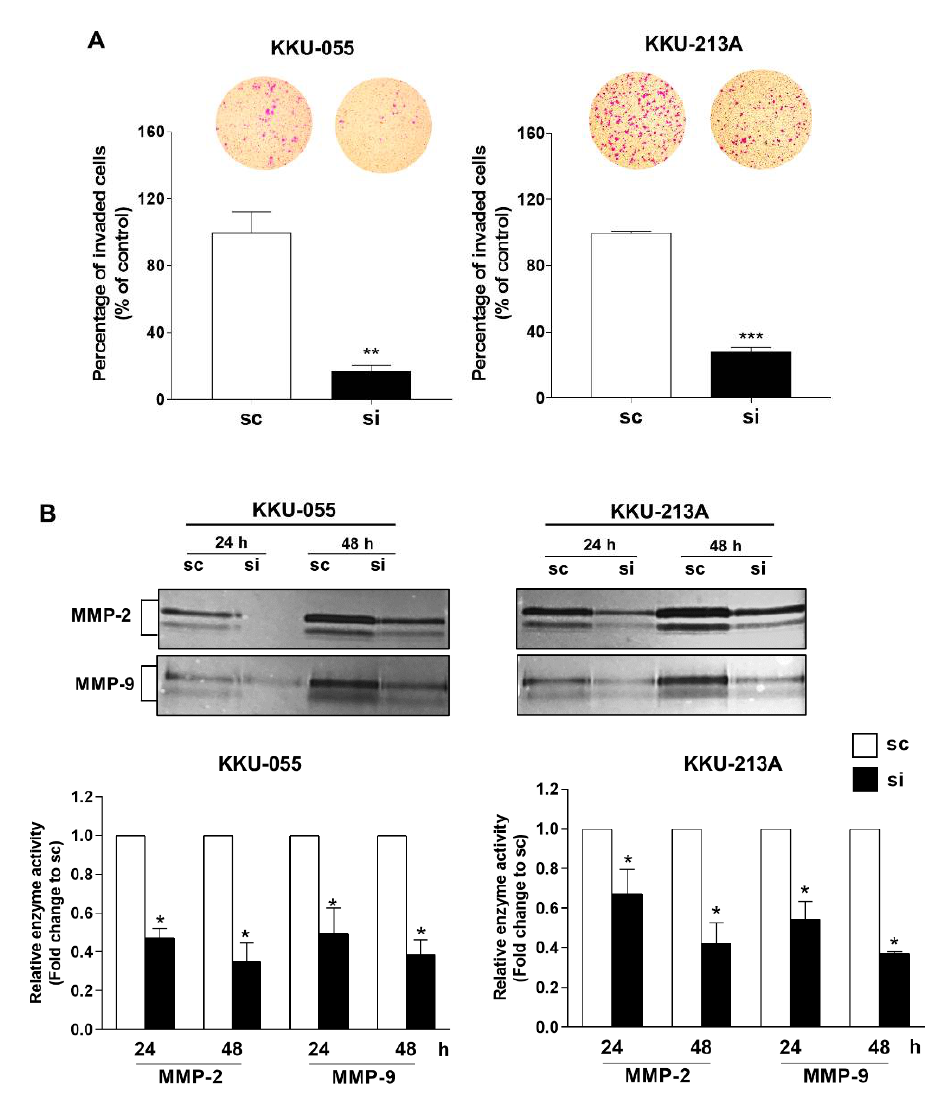
Figure 5. Suppression of MPS1 attenuated MMPs-dependent invasion in CCA cell lines. ( A ) The percentage of invaded cells after knocking down MPS1 in KKU-055 and KKU-213A cell lines. Results are mean ± SD of three independent experiments. ( B ) Gelatin zymogram of MMP-2 and MMP-9 activities in siMPS1-treated cells. The enzyme activity was relatively quantified to scramble (sc) control. Data are presented as mean ± SD from three independent experiments. * p < 0.05, ** p < 0.01 and *** p < 0.001.